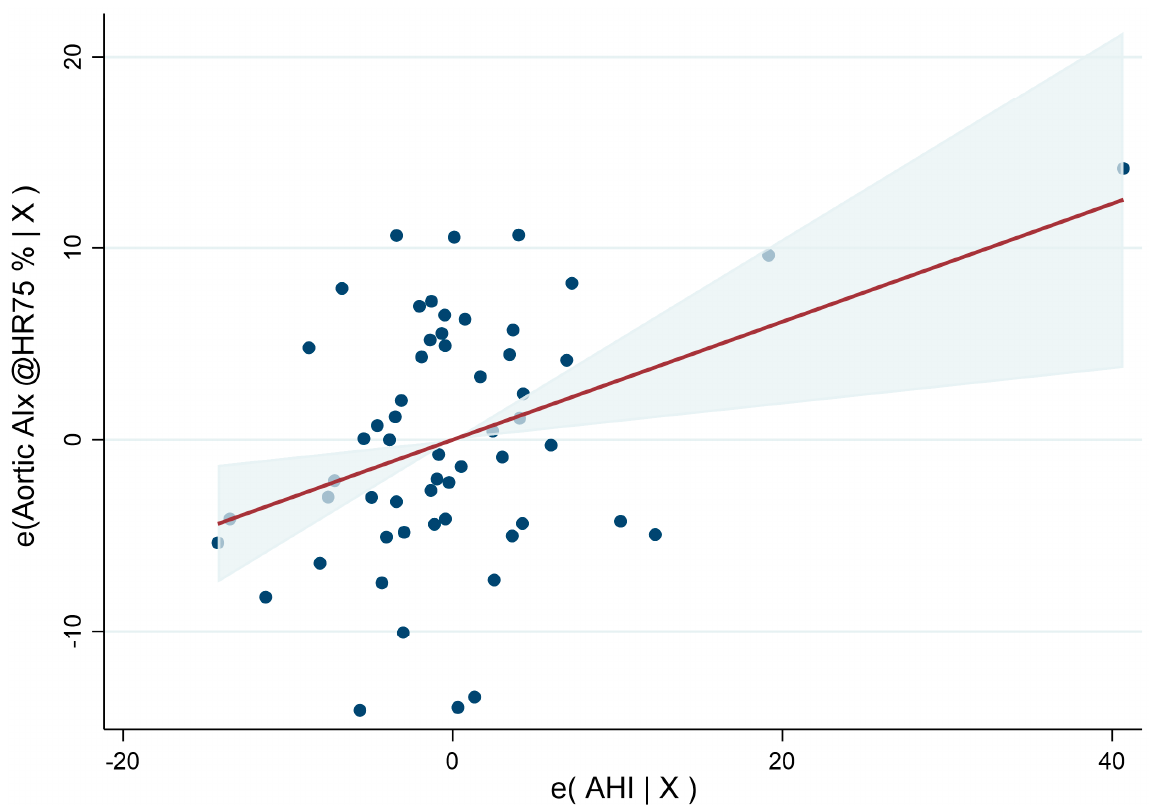
Figure 3. Added-variable plot with a 95% confidence interval between the aortic augmentation index (AIx) and apnea–hypopnea index (AHI) to display the relationship between AIx and AHI in the multivariable regression model. A higher AHI is associated with a higher Aix, while the adjusted variables (age, sex, height, systolic blood pressure, smoker, antihypertensive drug, and steroids) remained constant (Coef. 0.31, p = 0.006).